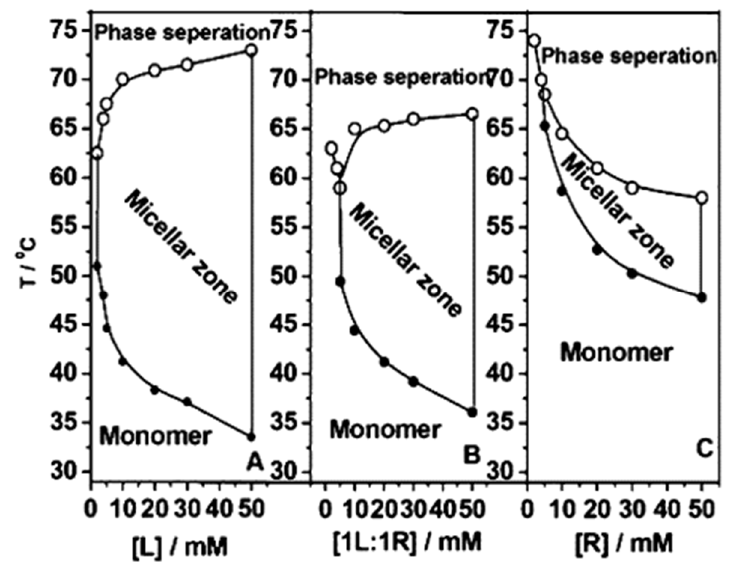
Figure 3. Comparative phase behavior of a normal Pluronic (L44), a reverse Pluronic (10R5) and a 1:1 mixture of both. Reproduced with permission from [15], Copyright American Chemical Society 2012.